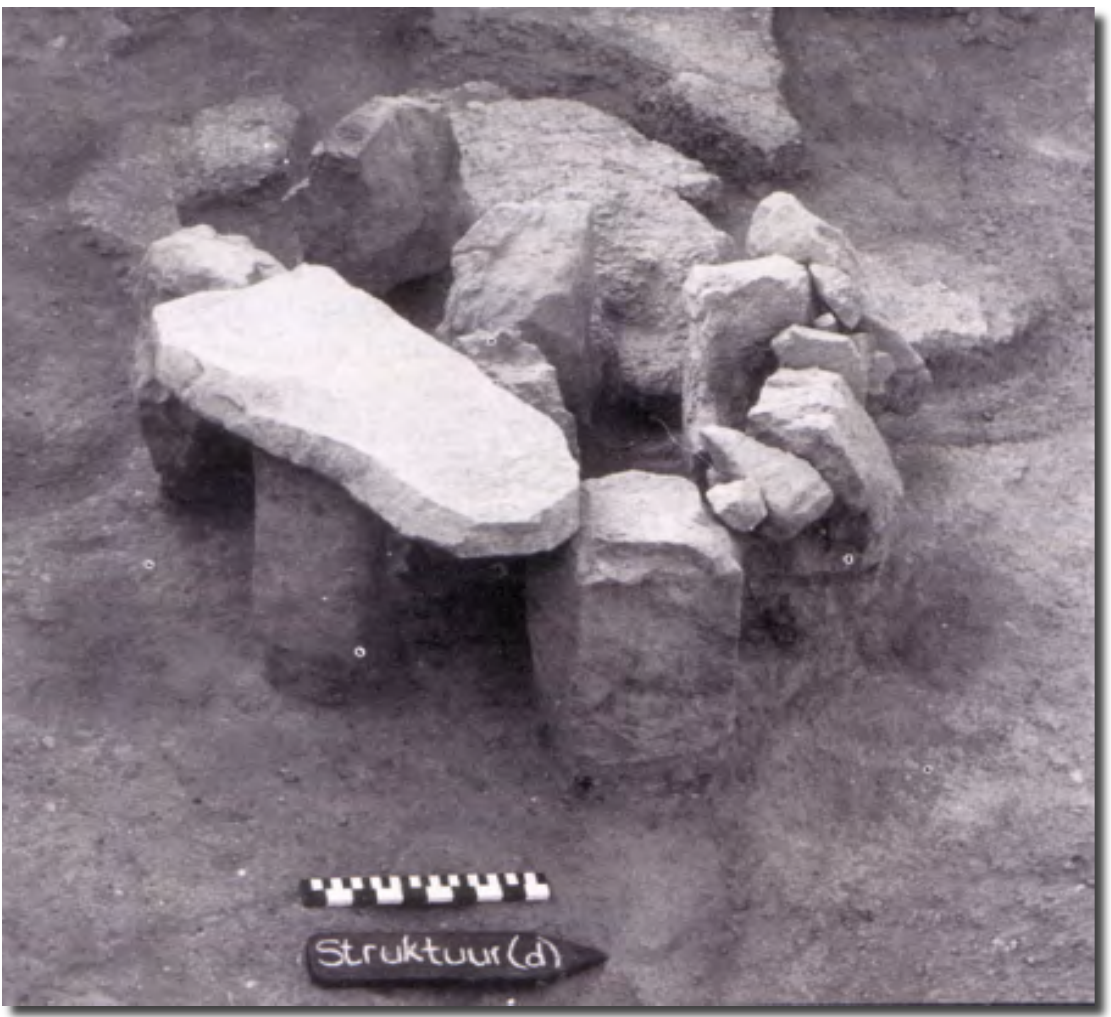
Figure 7. Stone platform consisting of columnar stones positioned vertically in a circle, some of which support a remaining flat stone (Meyer 1998:146, Figure